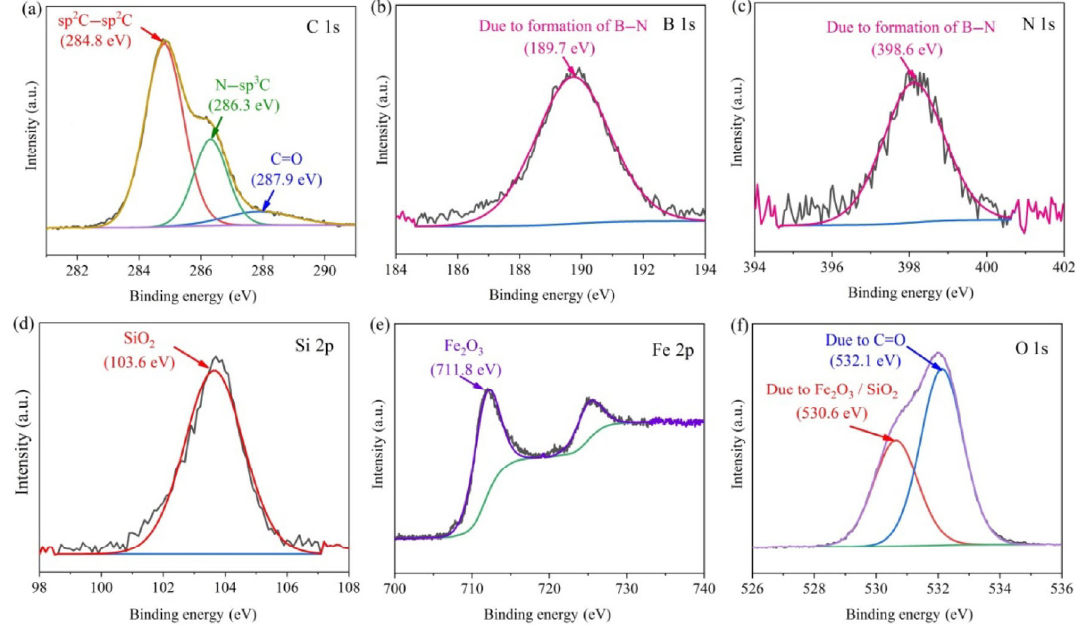
Fig. 9 XPS spectra of the worn surface with SiO 2 –B–N–GO lubrication under ASTM D5183 test conditions: (a) C 1s, (b) B 1s, (c) N 1s, (d) Si 2p, (e) Fe 2p, and (f) O